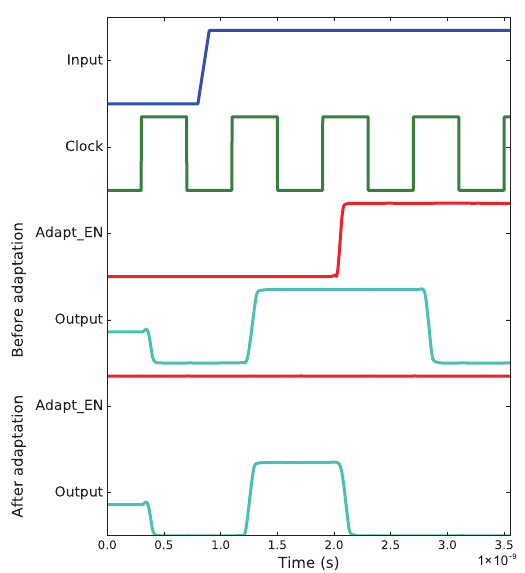
Figure 8. The Verification of Binning Checker and Binning Adaptor . Before adaptation, the Binning Critical Path fails at first capture, and it recovers at the second capture when the adaptation is enabled. After the adaptation status is kept into a directly accessible flash memory, the Binning Critical Path stays in the higher bin all the